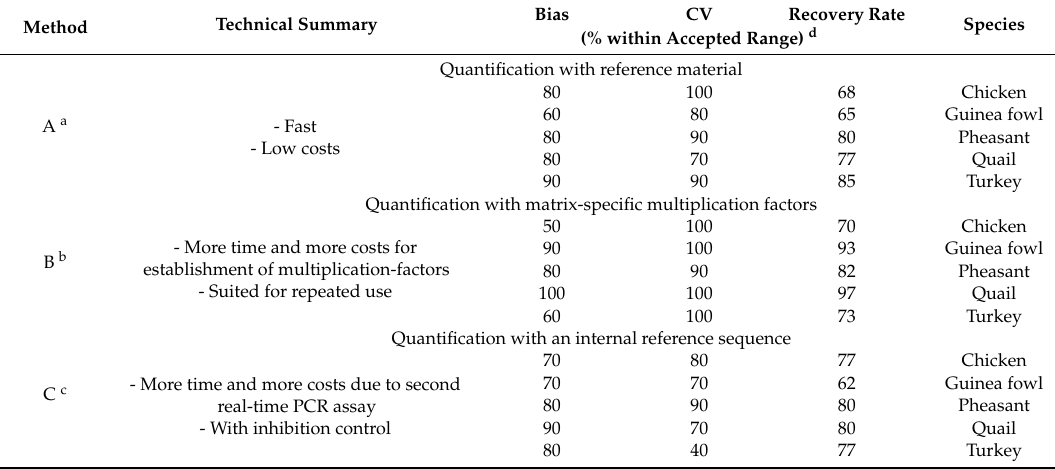
Table 8. Overview of the applied quantification methods, with percentages of accepted bias, coe ffi cients of variation (CV), and recovery